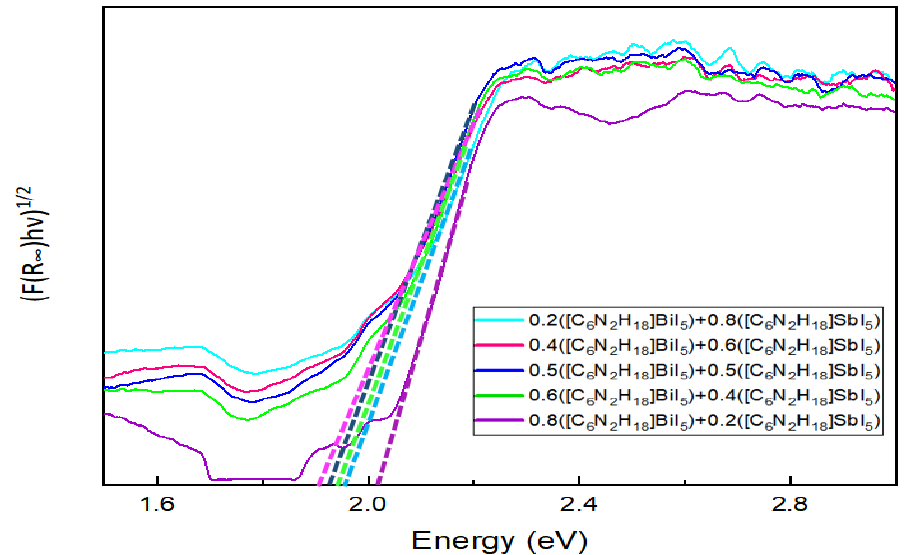
Figure 5. Plot of (ah ʋ ) 1/2 ~h ʋ for a multicomponent ferroelectric